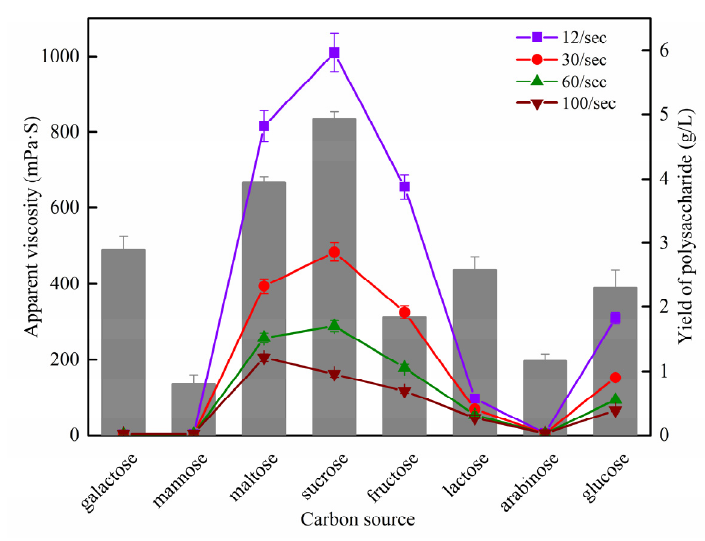
Figure 1. Comparison of the yield and rheological properties of exopolysaccharides (EPSs) from S. rolfsii ATCC 15205 with different carbon sources.